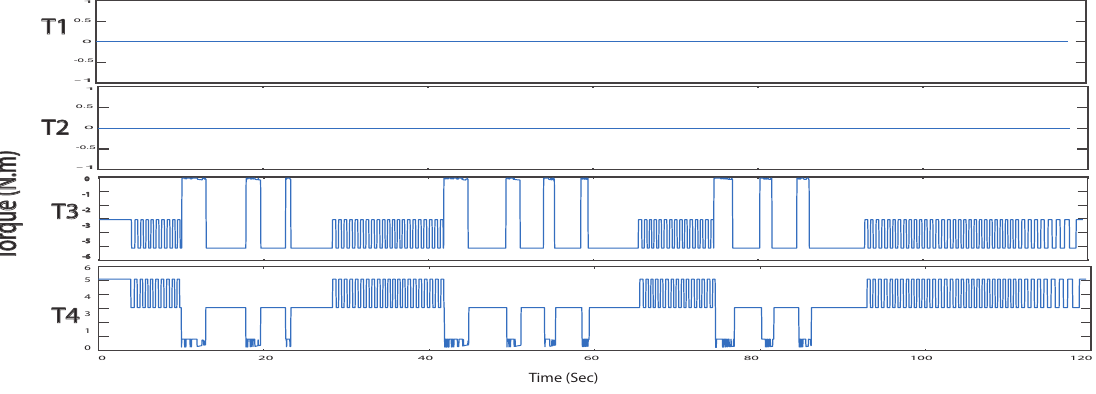
Figure 17. Simulation Results for State 5: Torque of motor 1,2,3,4.